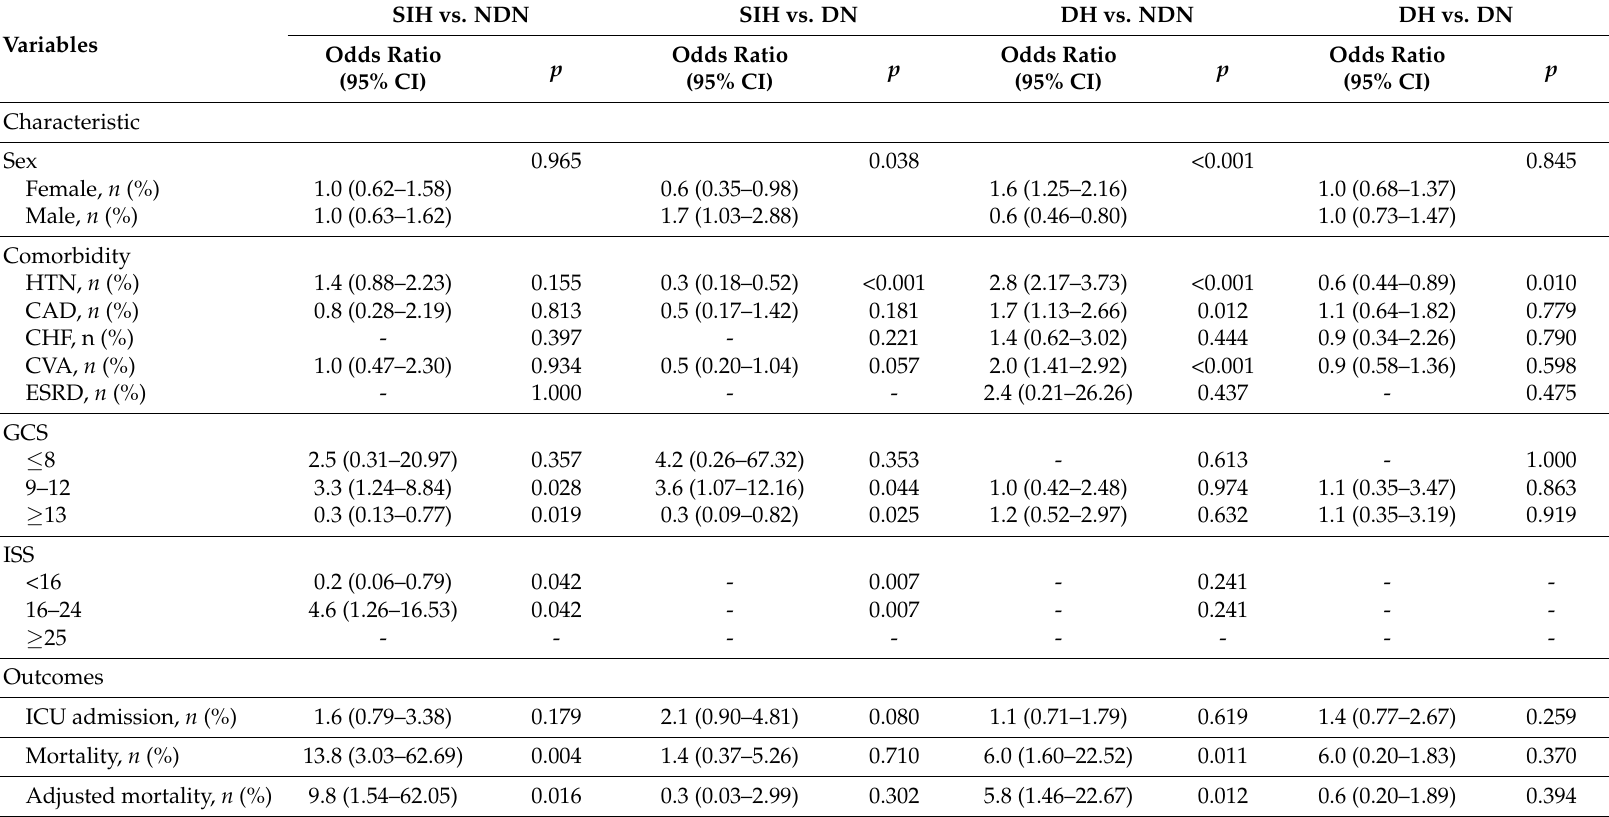
Table 2. Comparison of characteristics and outcomes of categorical variables between patient